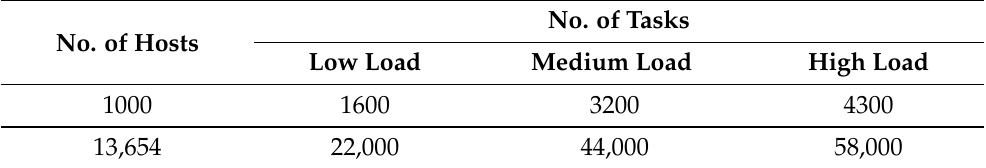
Table 1. Workload settings for the